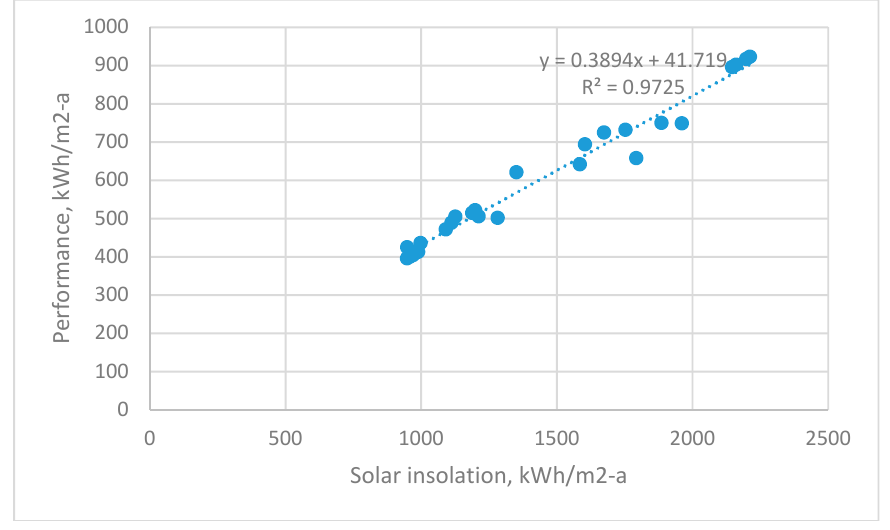
Figure 11. Linear regression model.